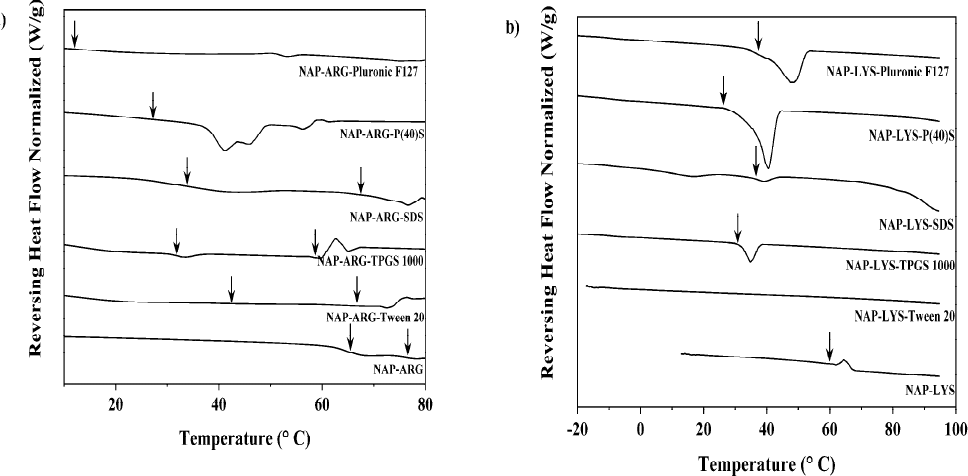
Figure 2. DSC results with T g s marked with an arrow for all compositions of naproxen and arginine (NAP-ARG) ( a ) or naproxen and lysine (NAP-LYS) ( b ), both with surfactant in the medium concentration.